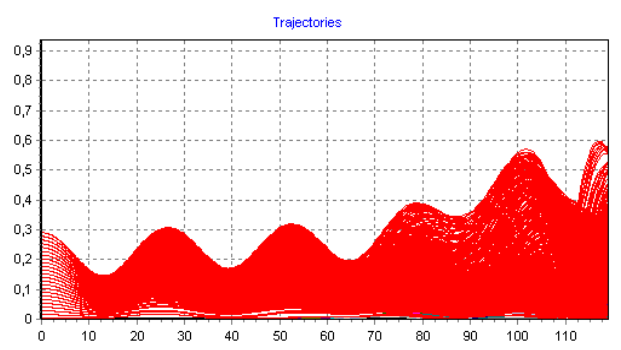
Fig. 6. Electron beam trajectories in the large-signal mode in a single-beam approximation. It can be seen from the calculation that the electron beam passes without total current fall. The TWT output parameters were calculated in a single-beam approximation, and the total tube power was 24 kW, a gain -17 dB and an efficiency – 28